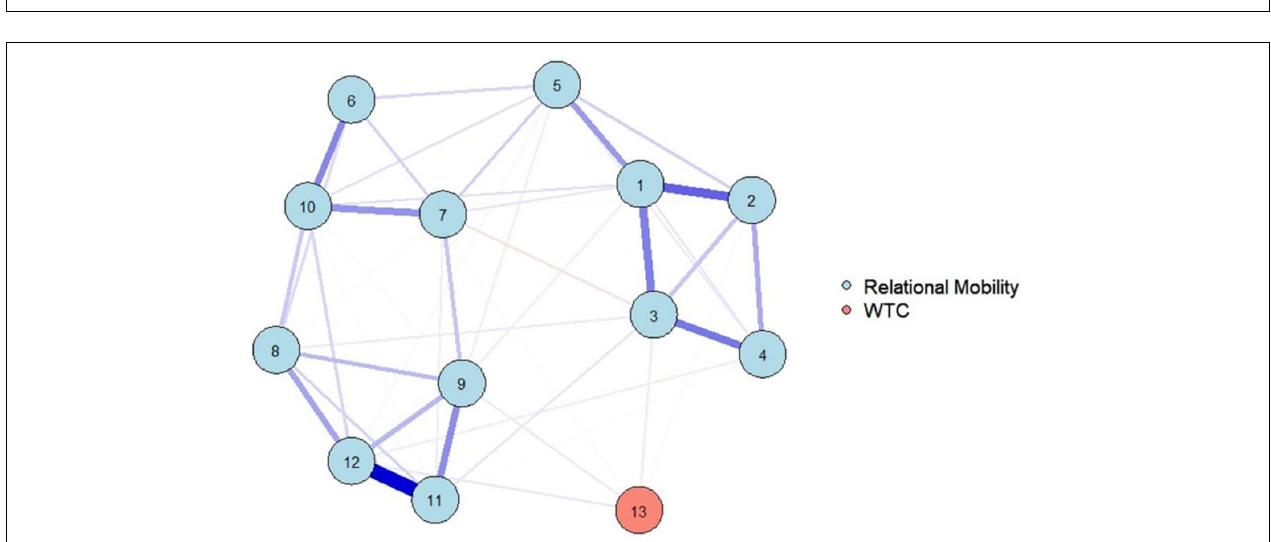
FIGURE 4 | The estimated network structure of relational mobility and WTC by bootstrapping methods. The network structure is a Gaussian graphical model, which is a network of partial correlation coefficients. Node numbers correspond to the variable numbers in “Materials and Methods” section, and No. 13 refers to WTC.